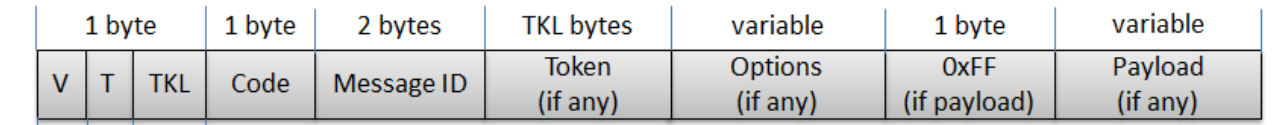
Figure 13. CoAP Message Format consisting of a 4-bytes base binary header followed by optional